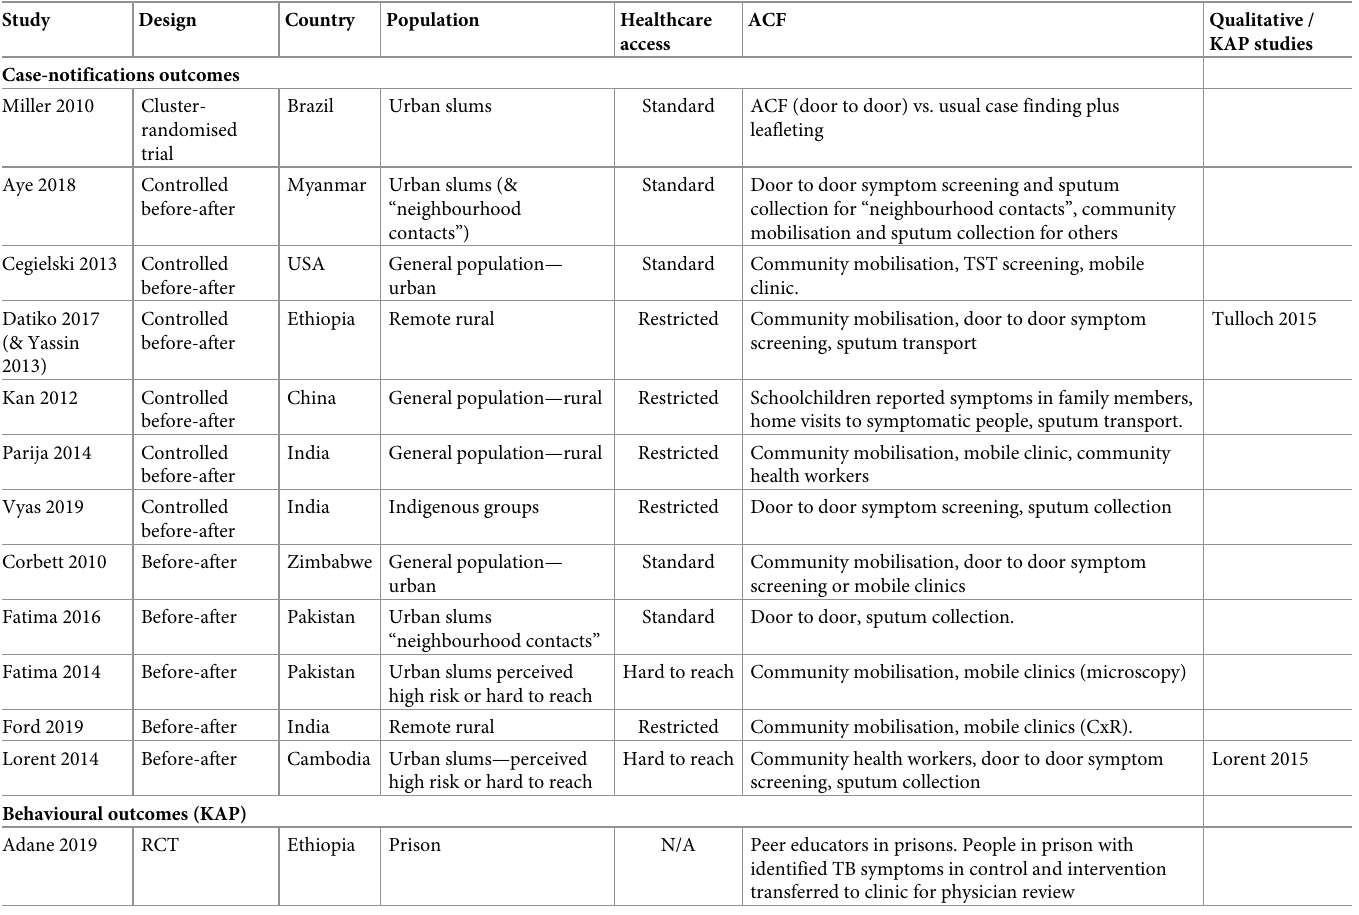
Table 1. Characteristics of included